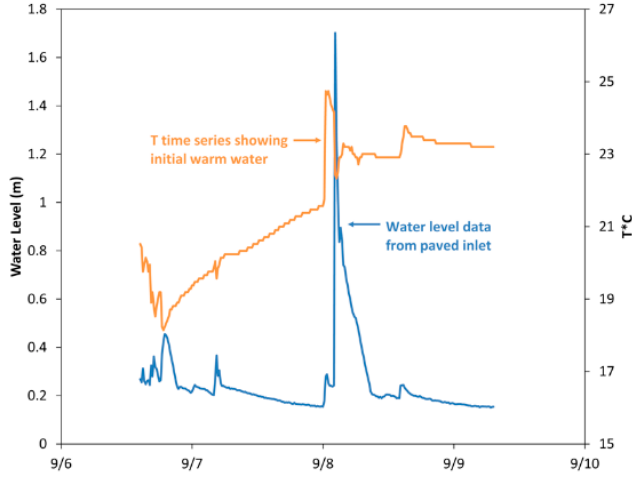
Figure 5. Water level response in parking lot infiltration trench and traditional storm pipe with a paved inlet. On 8 September 2011, the paved pipe had a higher response (see detail in Figure 6). Water 2016 , 8 , 346